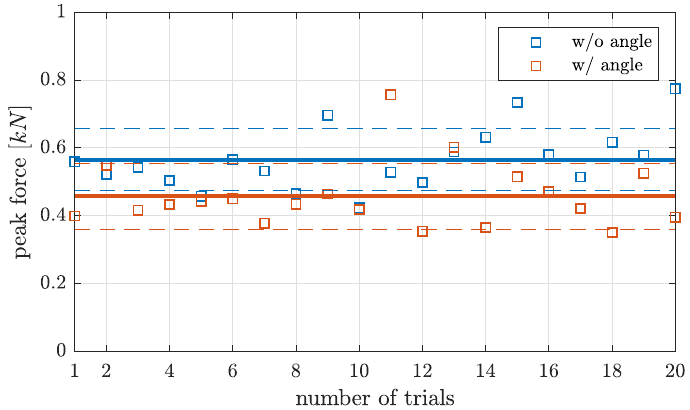
Figure 6. Linkage drop test